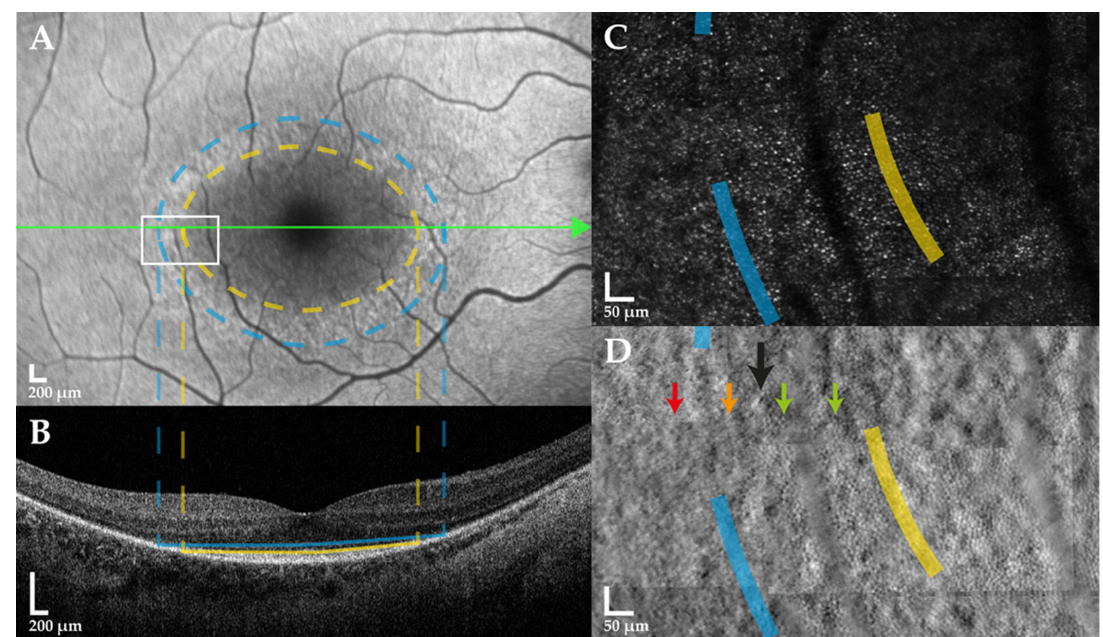
Figure 3. Multimodal retinal imaging in USH2A retinopathy. Fundus autofluorescence (FAF), spectral-domain optical coherence tomography (SD-OCT) and adaptive optics scanning laser ophthalmoscopy (AOSLO) images of the right eye in a 34-year-old female with USH2A -associated Usher syndrome type 2 are shown. The lateral borders of the inner (dashed yellow circle) and outer (dashed blue circle) hyperautofluorescent ring in ( A ) FAF spatially align with the lateral extents of the ellipsoid zone (solid yellow line) and external limiting membrane (solid blue line) bands, respectively, in the ( B ) SD-OCT horizontal B-scan through the foveal centre (horizontal green arrow). A magnified view of the ( C ) confocal and ( D ) split-detection AOSLO montage at the hyperautofluorescent ring (white rectangle) shows regular cone inner segments (vertical green arrows) until generalised disruption of the photoreceptor mosaic (vertical black arrow), beyond which cells are sparser (vertical amber arrow) followed by complete loss outside the outer ring (vertical red arrow).